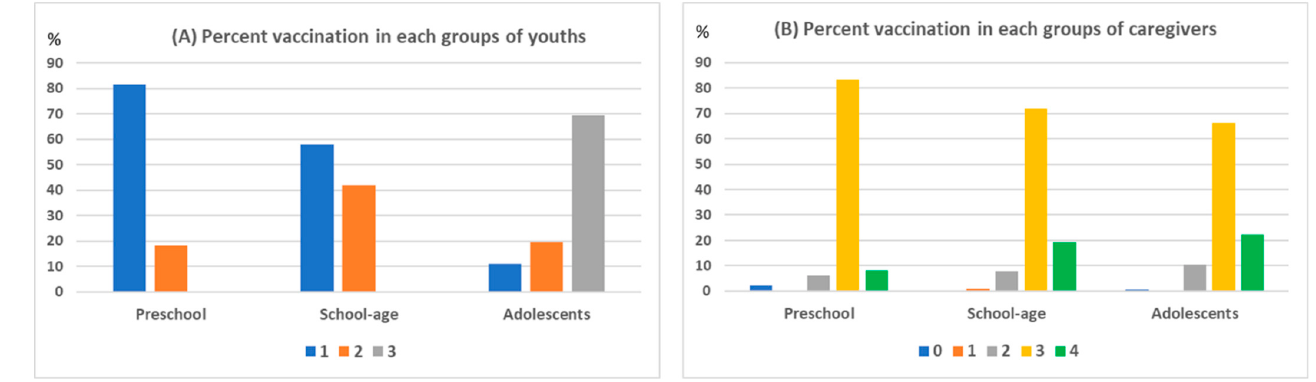
Figure 1. The proportion of vaccination numbers in three age groups of youths ( A ) and their